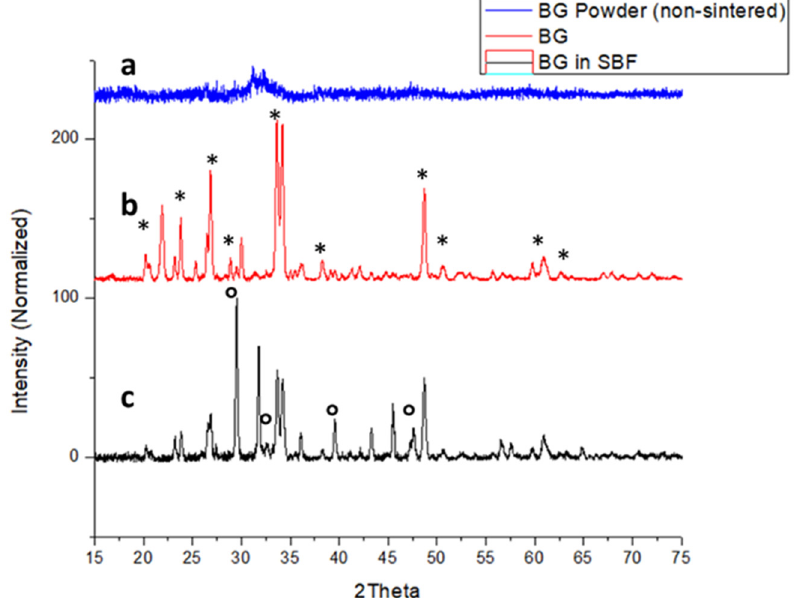
Figure 2 . ( a ) XRD of amorphous BG particles before sintering. ( b ) XRD of partially crystalline BG after sintering. Major peaks corresponding to the crystalline phase containing Na 2 Ca 2 Si 3 O 9 are marked with *. ( c ) Sintered bioglass after been immersed in simulated body fluid for 4 days. Presence of HA can be seen, as indicated by ° .